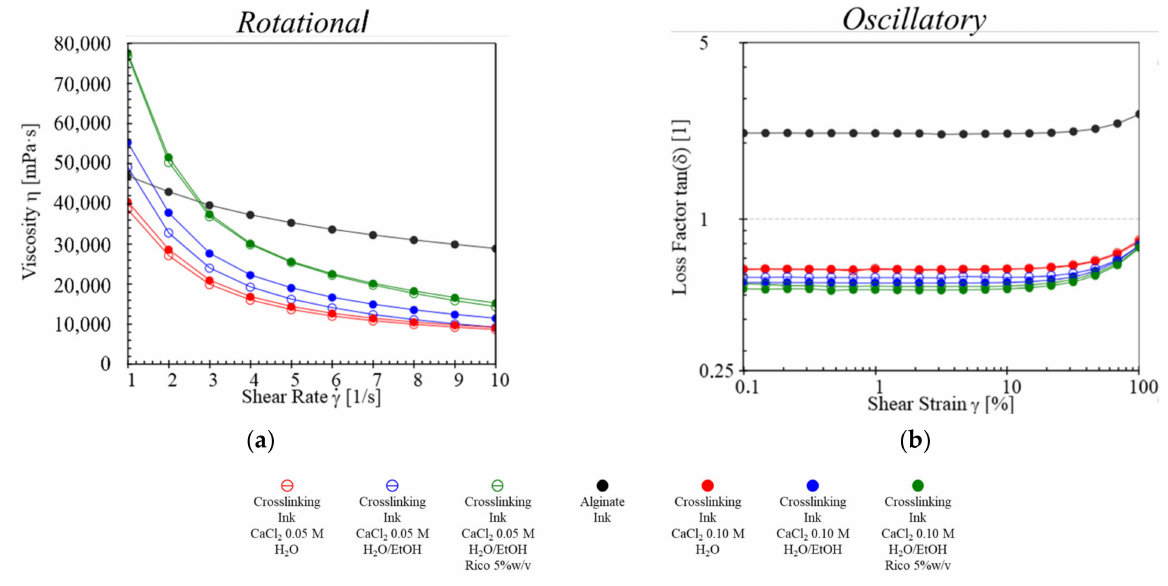
Figure 1. Results from rotational test ( a ) and amplitude sweep test ( b ) for crosslinking and algi- nate inks.